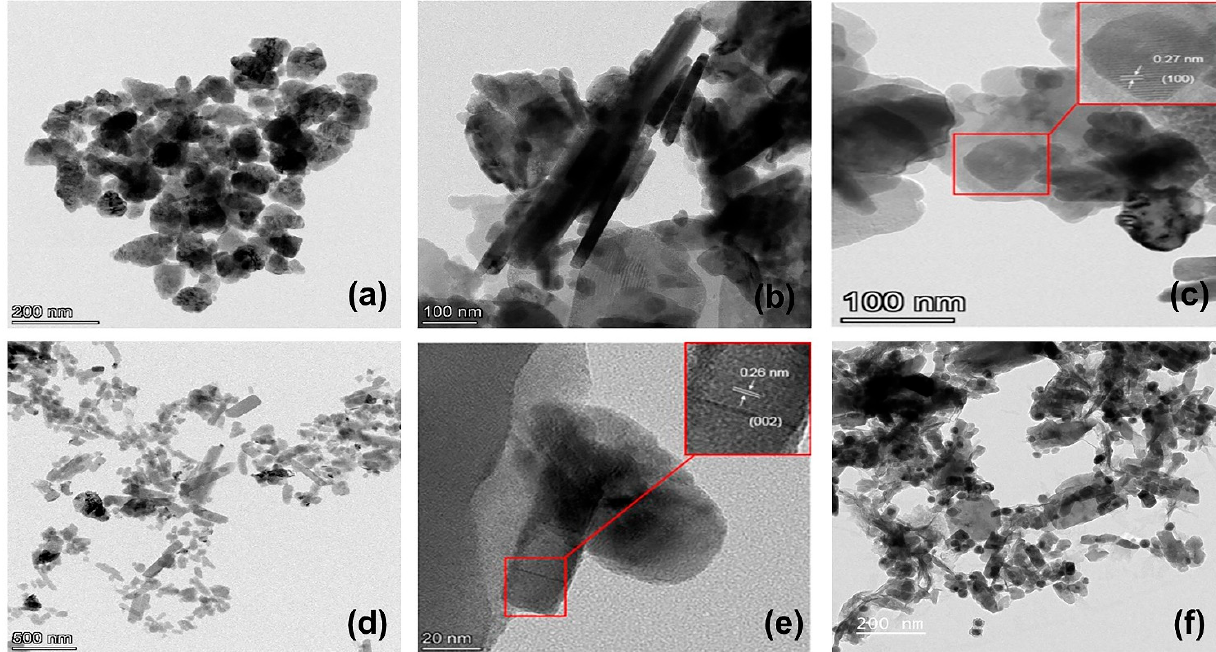
Figure 3. ( a ) TEM image of ZnO NPs, ( b ) TEM and ( c ) HRTEM images of ZnO NPs-GABA, ( d ) TEM and ( e ) HRTEM images of ZnO NPs-GABA-CurBF 2 , and ( f ) TEM image of ZnO NPs-GABA/CurBF 2 -AgNPs.